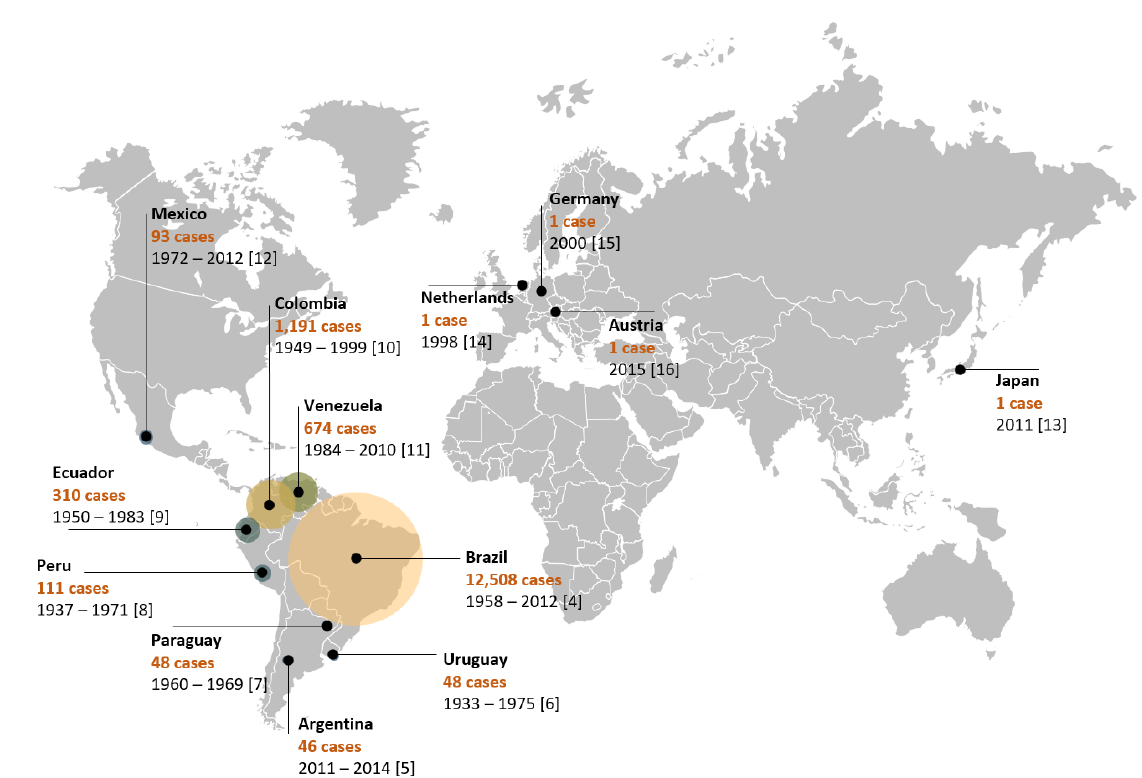
Figure 1. Epidemiological distribution of PCM cases throughout the world. The Netherlands, Germany, Austria, and Japan have imported cases. Legends show the name of the country and the number of cases identified through the period mentioned in each study.